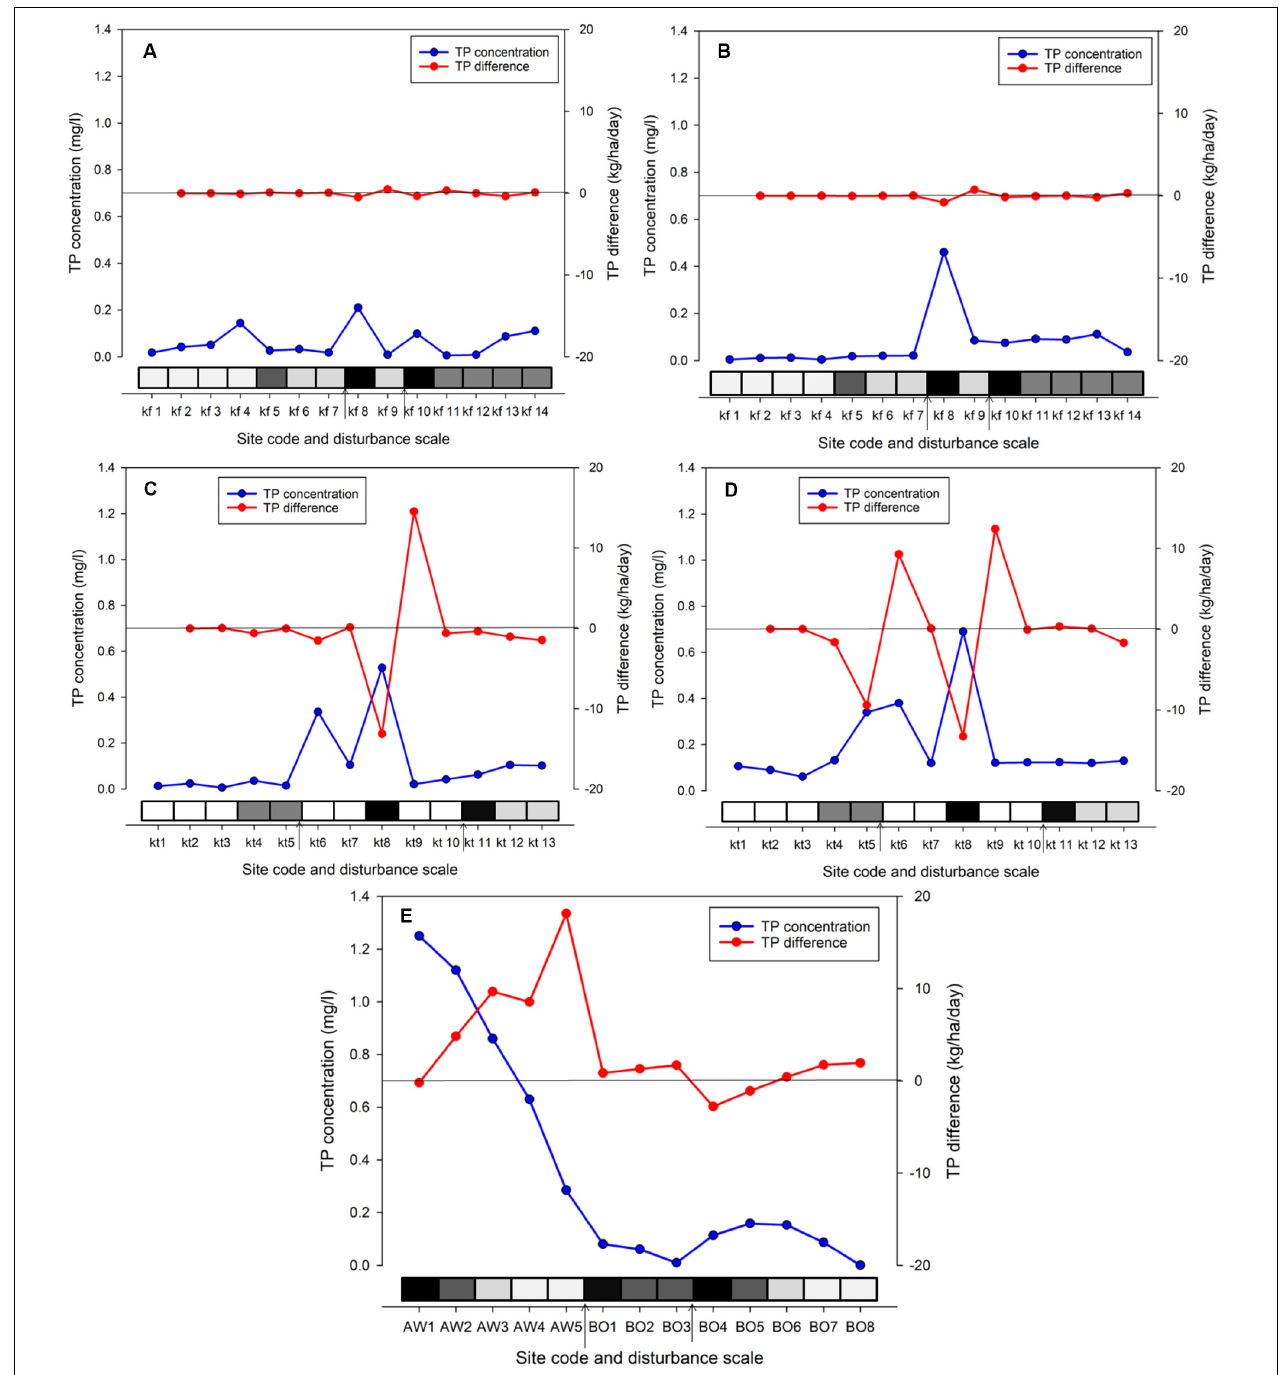
FIGURE 4 | Total Phosphorous (TP) concentration and difference in Kofe (A) , Kito (C) and Awetu-Boye (E) wetlands during wet season and Kofe (B) and Kito (D) during the dry season. Disturbance condition along the wetland ranged from very low (white) to very high (black). A black arrow indicates a site where a tributary enters into the main